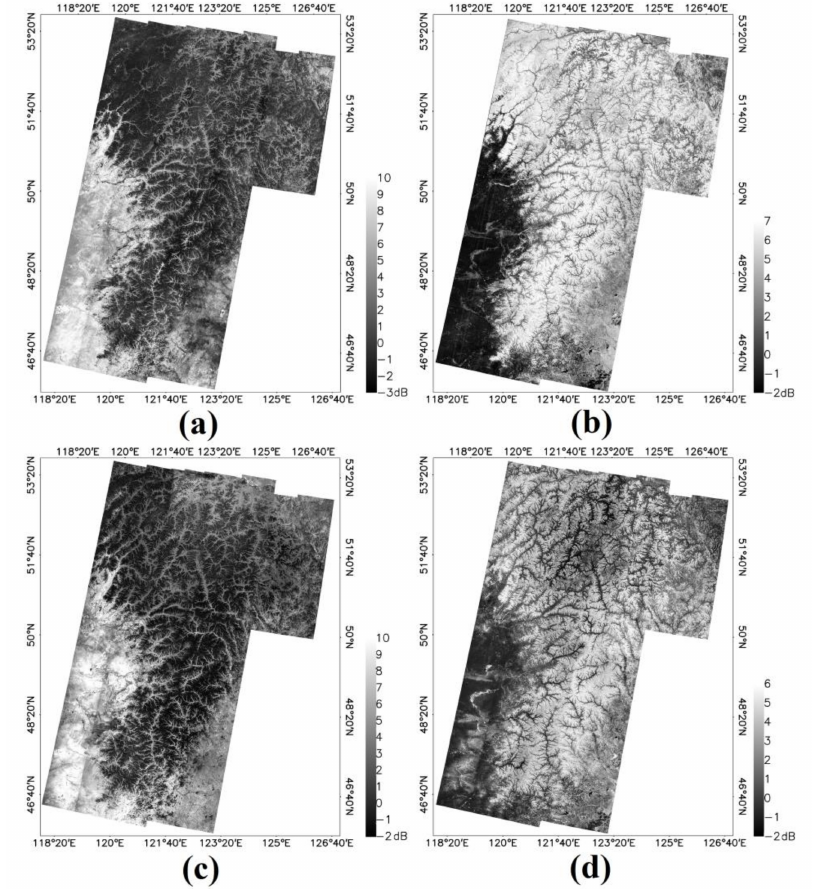
− σ 0 using Sentinel-1A Date 2 Date 1 − σ 0 using Sentinel-1B in 2018; Date 2 Date 1